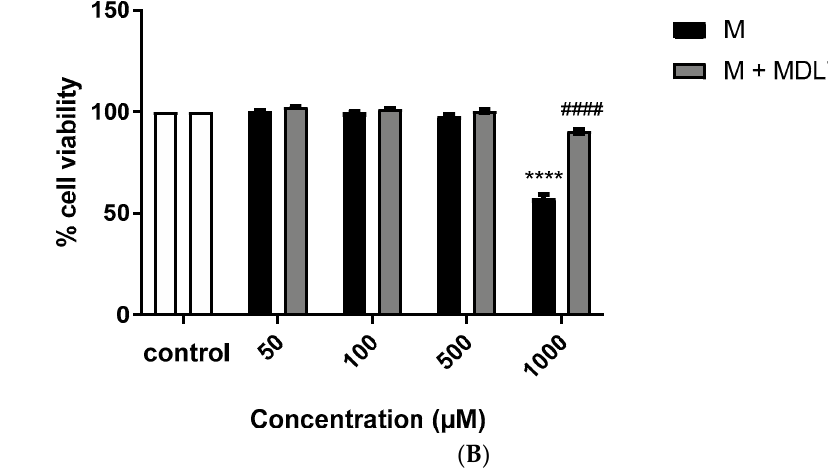
Figure 1. Active SSAO induces VSMCs death, expressed as percentages of cell viability (MTT assay). VSMCs were treated with increasing concentrations of aminoacetone (AA), or AA + 100 µM irreversible SSAO inhibitor MDL72527 ( A ) and increasing concentrations of methylamine (M), or M + 100 µM irreversible SSAO inhibitor MDL72527 ( B ). For figure ( A ), * p < 0.05 for 50 µM AA vs. control and **** p < 0.0001 for 100 µM AA vs. control (two-way ANOVA followed by Dunnett’s); # p < 0.05 for 10 µM AA + 100 µM MDL72527 vs. AA; ### p < 0.001 for 50 µM AA + 100 µM MDL72527 vs. AA; #### p < 0.0001 for 100 µM AA + 100 µM MDL72527 vs. AA (two-way ANOVA followed by Tukey’s). For figure ( B ) **** p < 0.0001 for 1000 µM M vs. control (two-way ANOVA followed by Dunnett’s); #### p < 0.0001 for 1000 µM M + 100 µM MDL72527 vs. M (two-way ANOVA followed by Tukey’s). Values are mean ± S.E.M. (n = 5).